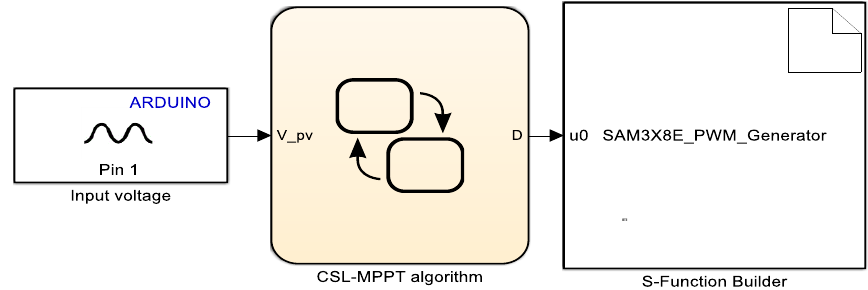
Figure 18. The Simulink model of the CSL controller loaded to the target hardware.